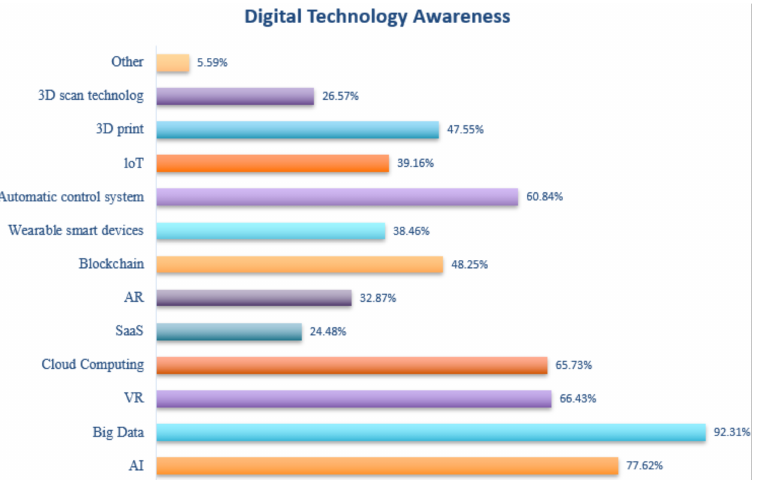
Figure 6. Comparison of digital technology awareness. Note: The figure is mapped based on the questionnaire